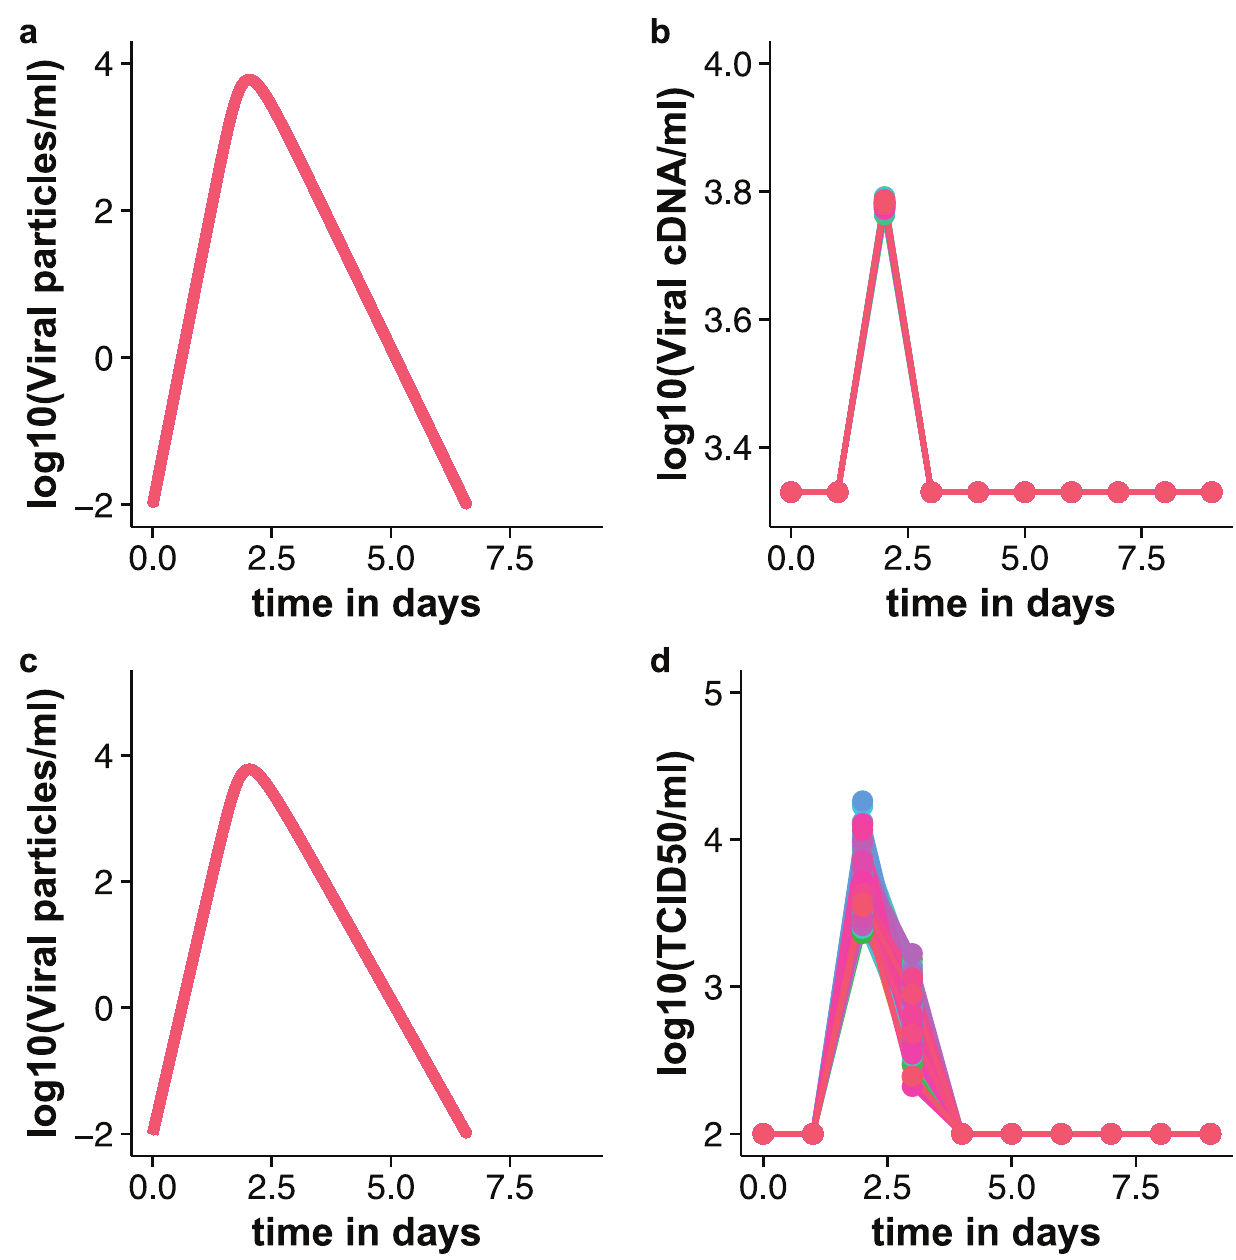
Fig 2. Variance of viral load measurements. For this figure we simulated influenza virus infection in 1000 patients that all had the same natural course of infection. For each of the patients, viral load measurements were generated, simulating qPCR (upper row) and TCID 50 assays (lower row). The variance of the TCID 50 assay (lognormal distribution) is greater than that of the qPCR assay (Poisson distribution). The variance of the viral load assays is small compared to the variation in natural infection among patients. Upper row: qPCR measurements, unit: viral cDNA/ml. Lower row: TCID 50 measurements, unit TCID 50 /ml. a, c: True (simulated) viral load curves of 1000 patients with same course of natural infection. b, d: simulated measurements of 1000 patients with the same natural course of infection. b: lower limit of quantification of the PCR assay was 3.33 log 10 cDNA/ml (2137 cDNA/ml), d: lower limit of quantification of TCID 50 assay was 2 log 10 TCID 50 / ml (100 TCID 50